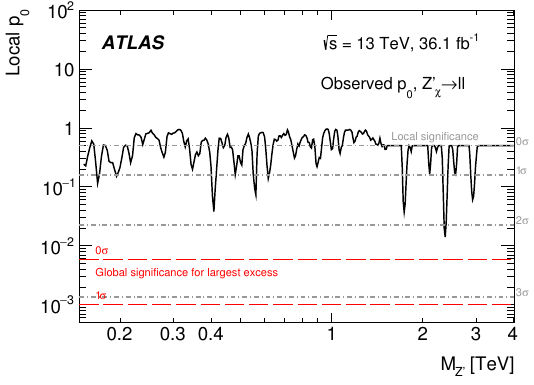
Figure 2 . The local p -value derived assuming Z 0 signal shapes with pole masses between 0.15 and (cid:31) 4.0 TeV for the combined dilepton channel. Accompanying local and global signi(cid:12)cance levels are shown as dashed lines. The uncapped p 0 value is used for pole masses below 1.5 TeV, while the capped p 0 value is used for higher pole masses.